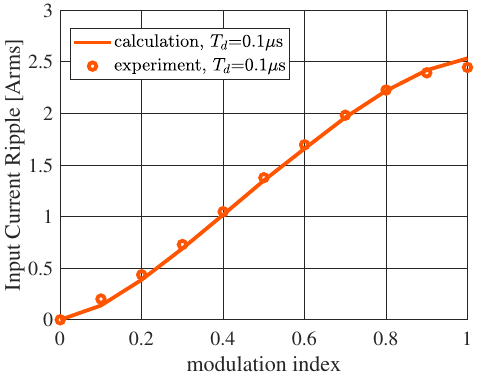
Figure 17. Calculation and experimental results of modulation index vs. rms input current ripple of the three-phase VSI (case 2 load, T d = 0.1 µ s).